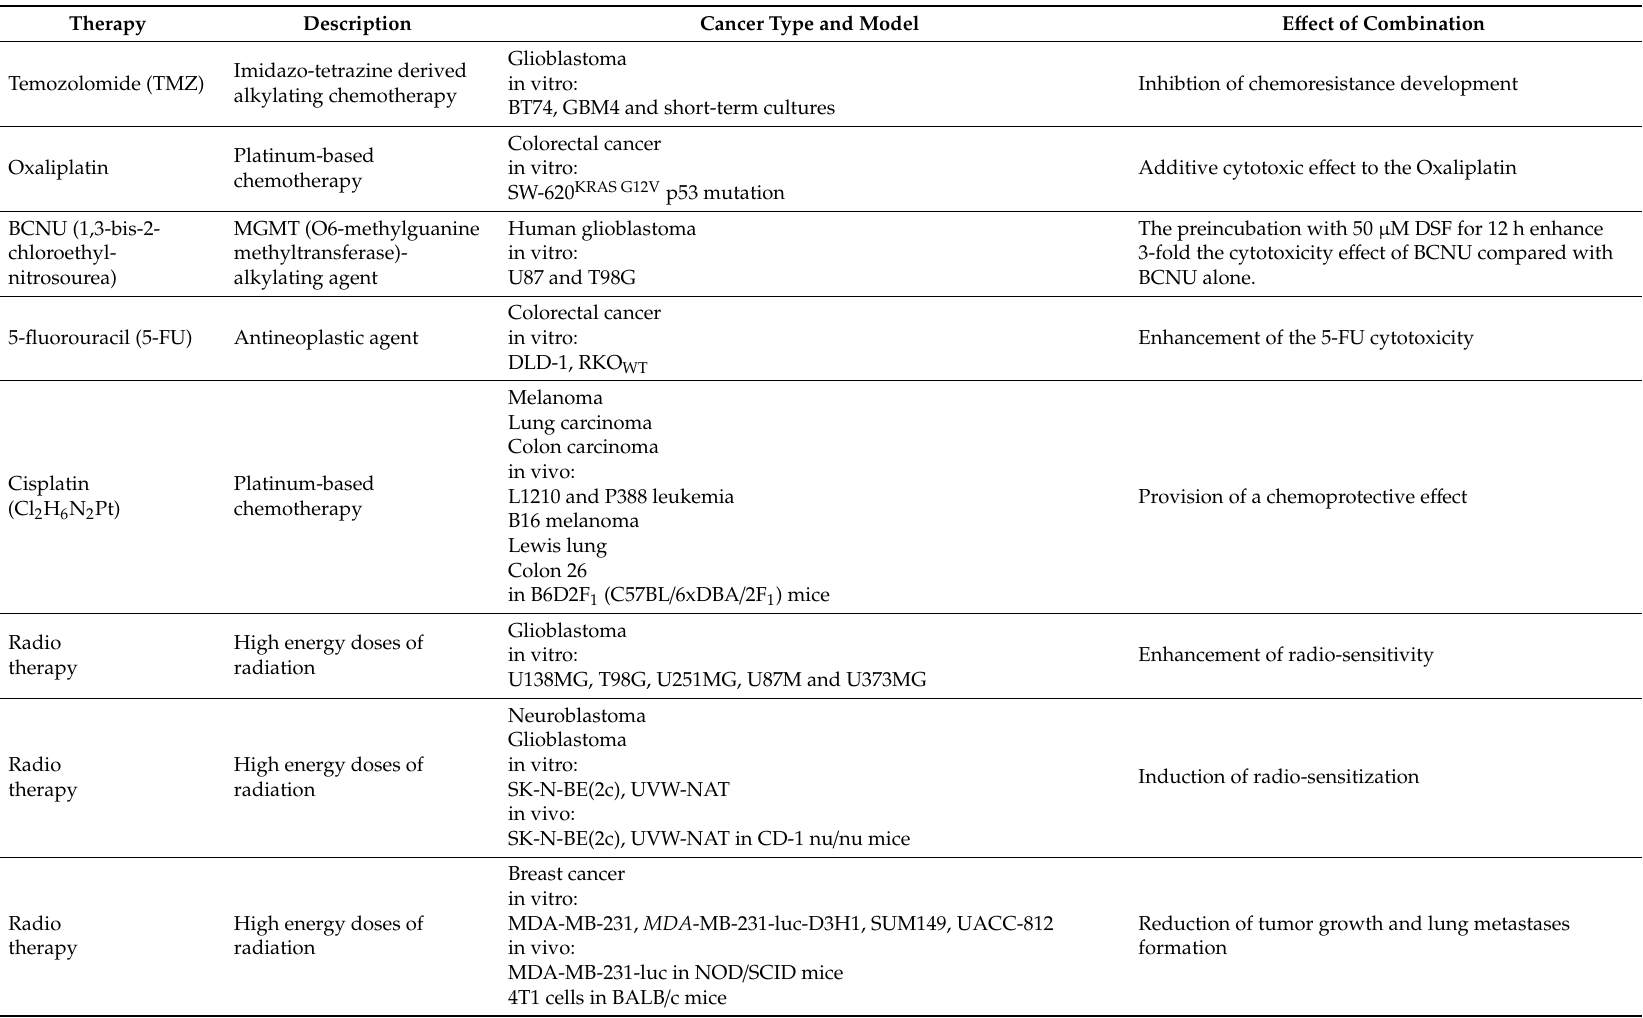
Table 3. Disulfiram and drug / therapy